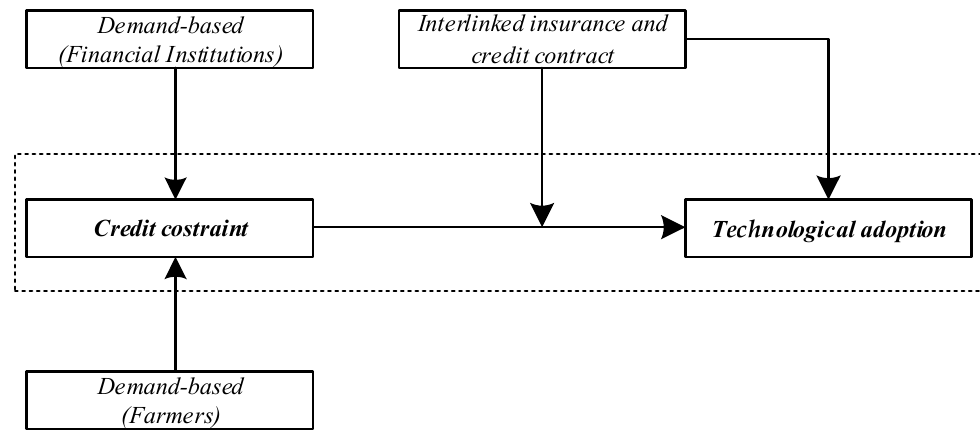
Figure 1. Mechanism analysis.